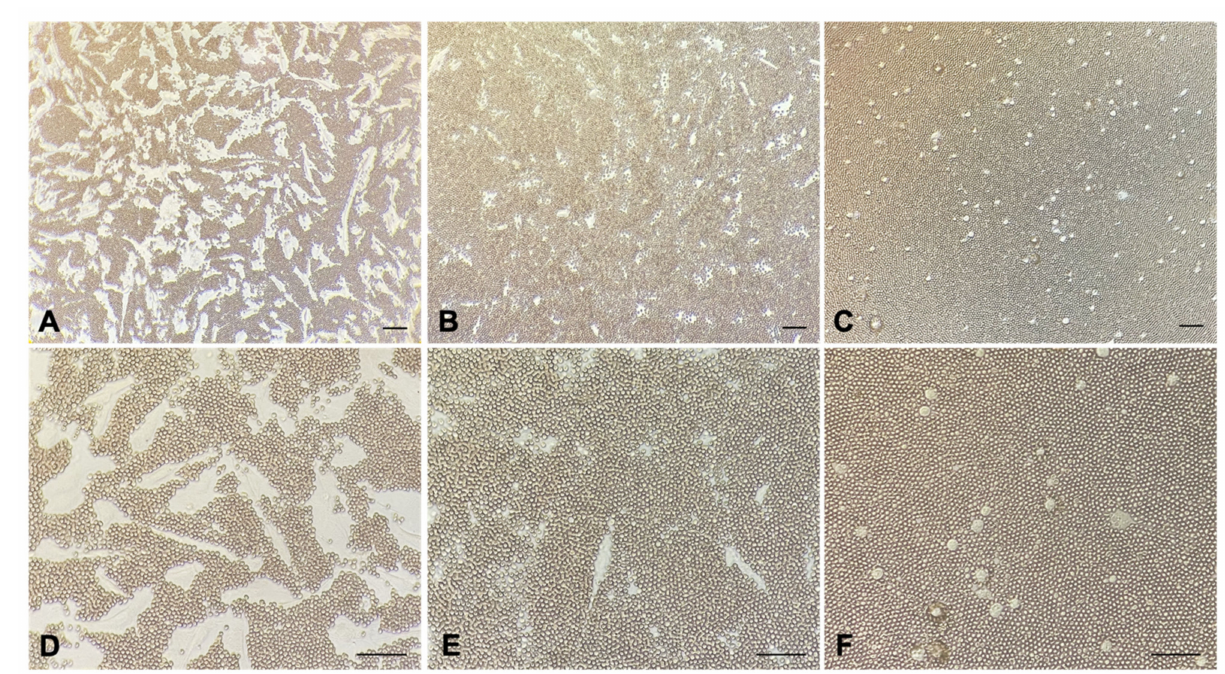
Figure 2. Red blood cell (RBC) exclusion assay in MPM primary cells with or without hyaluronidase treatment and in Met5A cells. Fixed RBCs were added onto MPM primary cells in the culture, highlighting the presence of a HA pericellular coat around the cells ( A , D ); hyaluronidase treatment ( B , E ) was performed to confirm the coat as being composed of HA. As an additional control, the same experiment was carried out with Met5A ( C , F ). Original magnification, 100 × ( A – C ), 200 × ( D – F ), scale bar, 50 µ